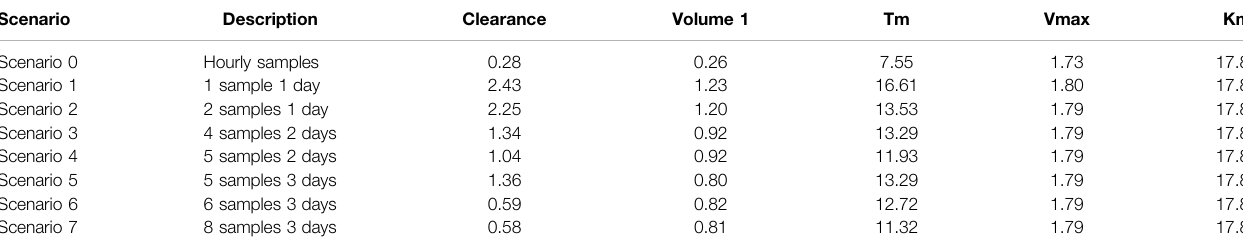
TABLE 2 | RMSE of evaluated dosing regimens.